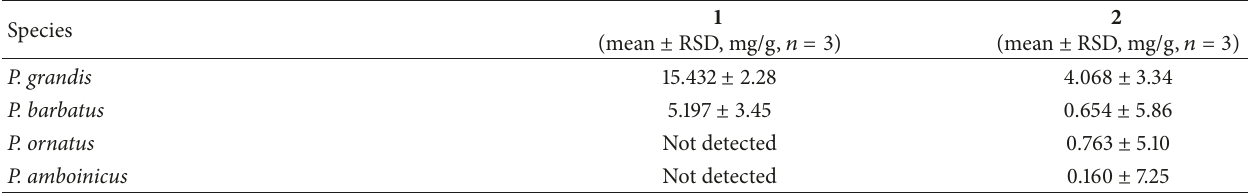
Table 3: Concentration of diterpenes 1 and 2 in leaves of Plectranthus species.